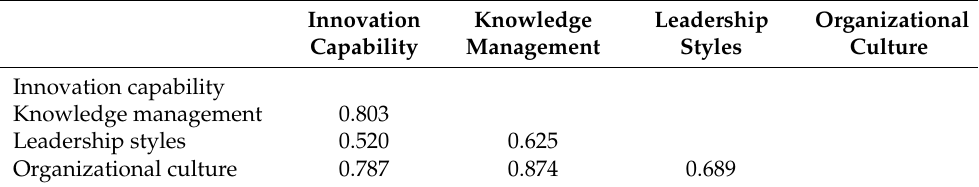
Table 5. Heterotrait–Monotrait Ratio (HTMT).